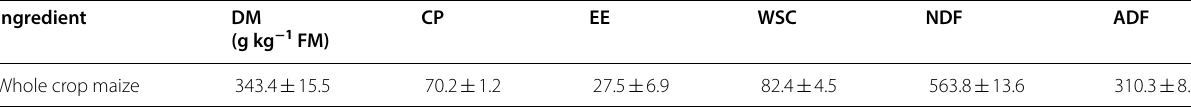
Table 1 The nutrient composition (g kg − 1 DM, unless stated otherwise) of whole crop maize Ingredient Whole crop FM: Fresh weight; DM: dry matter; CP: crude protein; EE: ether extract; WSC: water soluble carbohydrate; NDF: neutral detergent fibre; ADF: acid detergent fibre